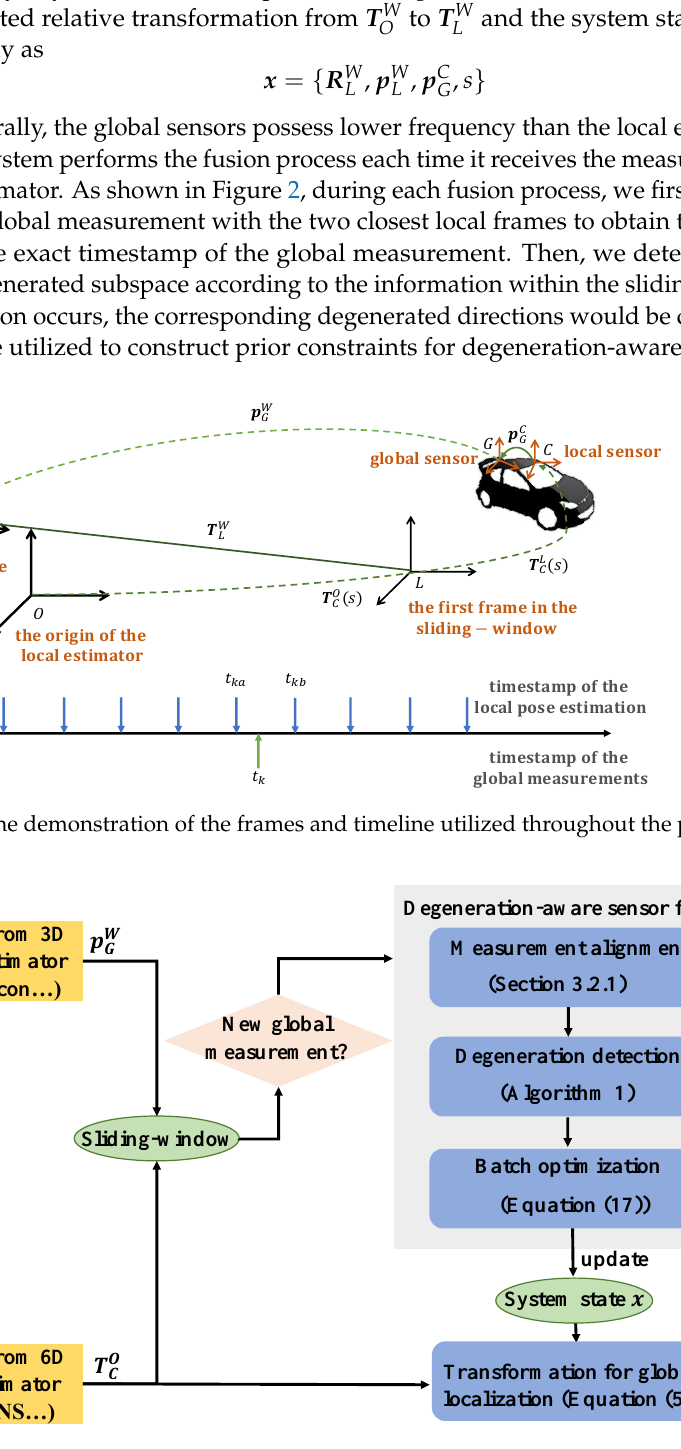
Figure 2. The pipeline of the proposed degeneration-aware sensor fusion